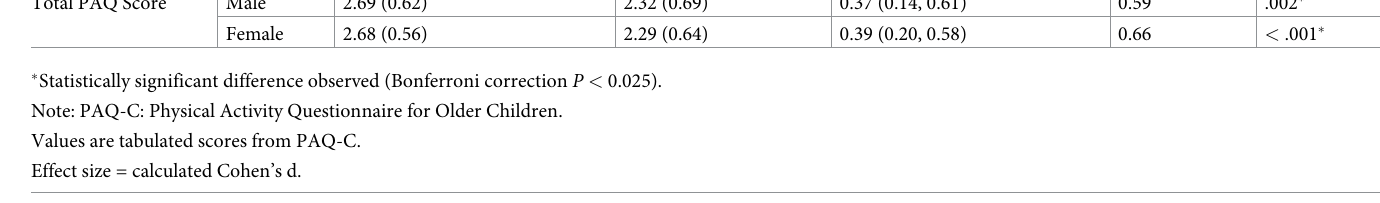
the mean PAQ-C total scores between pre-COVID and COVID lockdown, t (302) = 5.118., p < .001, d = . 63 , with a mean difference of .385 (95% CI: .237, .532). After a Bonferroni correction, independent samples t -tests compared answers on nine indi- vidual questions of the PAQ-C. Significant differences between pre-COVID and COVID lock- down mean scores were noted for: Spare time (Q1) t (239.2) = 3.39., p = .001, d = .38, before